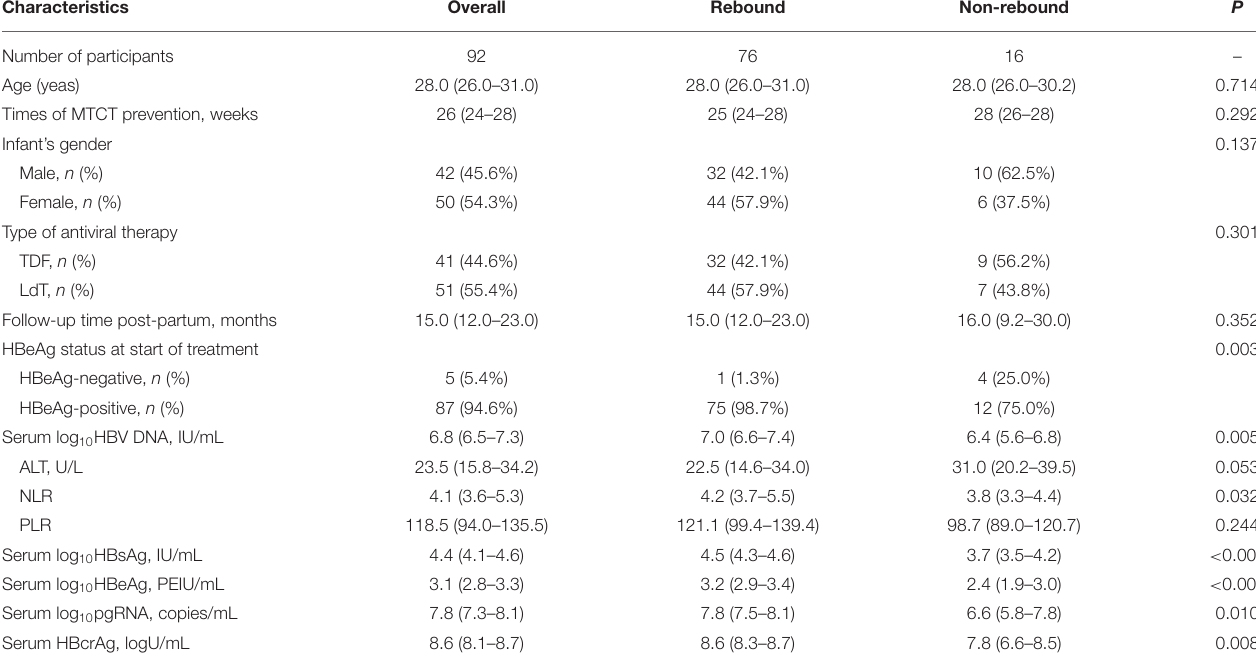
TABLE 1 | Clinical characteristics of 92 recruited participants with MTCT prevention at baseline a .